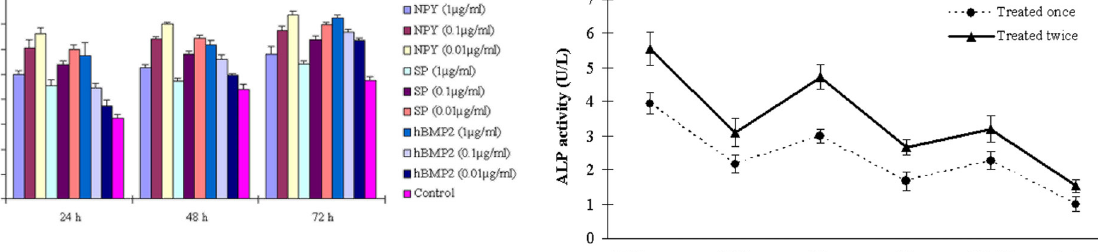
Figure 2. Cell viability assays. The graph shows the viability index of osteoblasts (absorbance) exposed to neuropeptide Y (NPY), substance P (SP) and human bone morphogenetic protein 2 (hBMP2). The absorbance was significantly different among the three treatments (P , 0.05, ANOVA) and increased over time. Additionally, for the two neuropeptides, absorbance increased as the concentration decreased. However, for hBMP2, absorbance decreased as its concentration decreased.